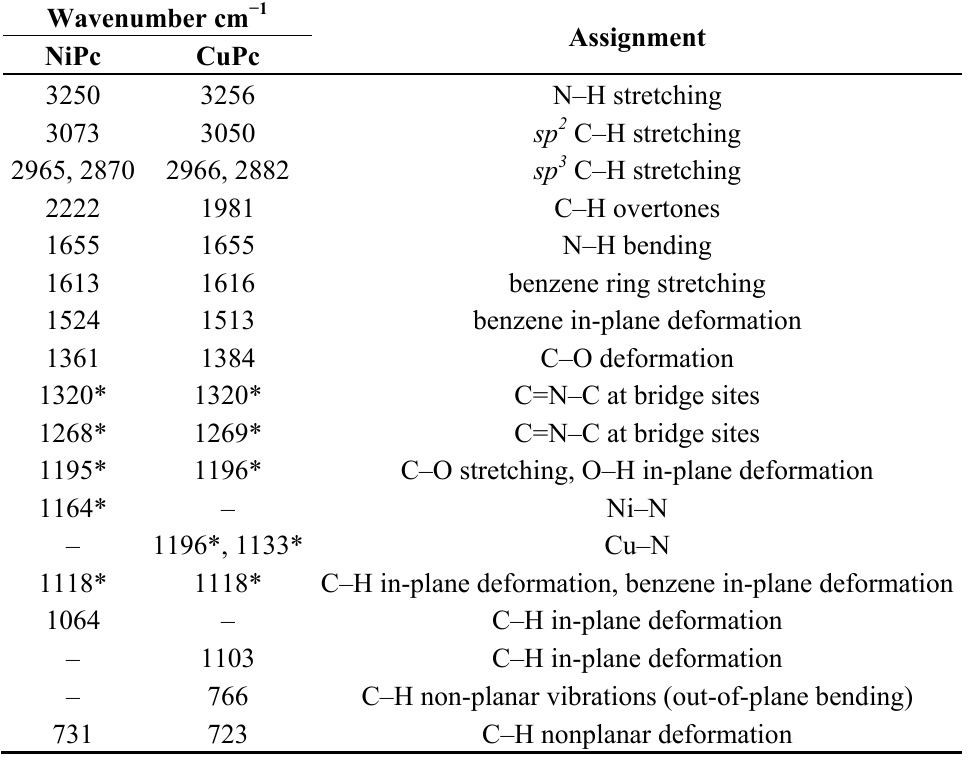
Table 3. Assignments of the FT-IR characteristic peaks of the NiPc and CuPC